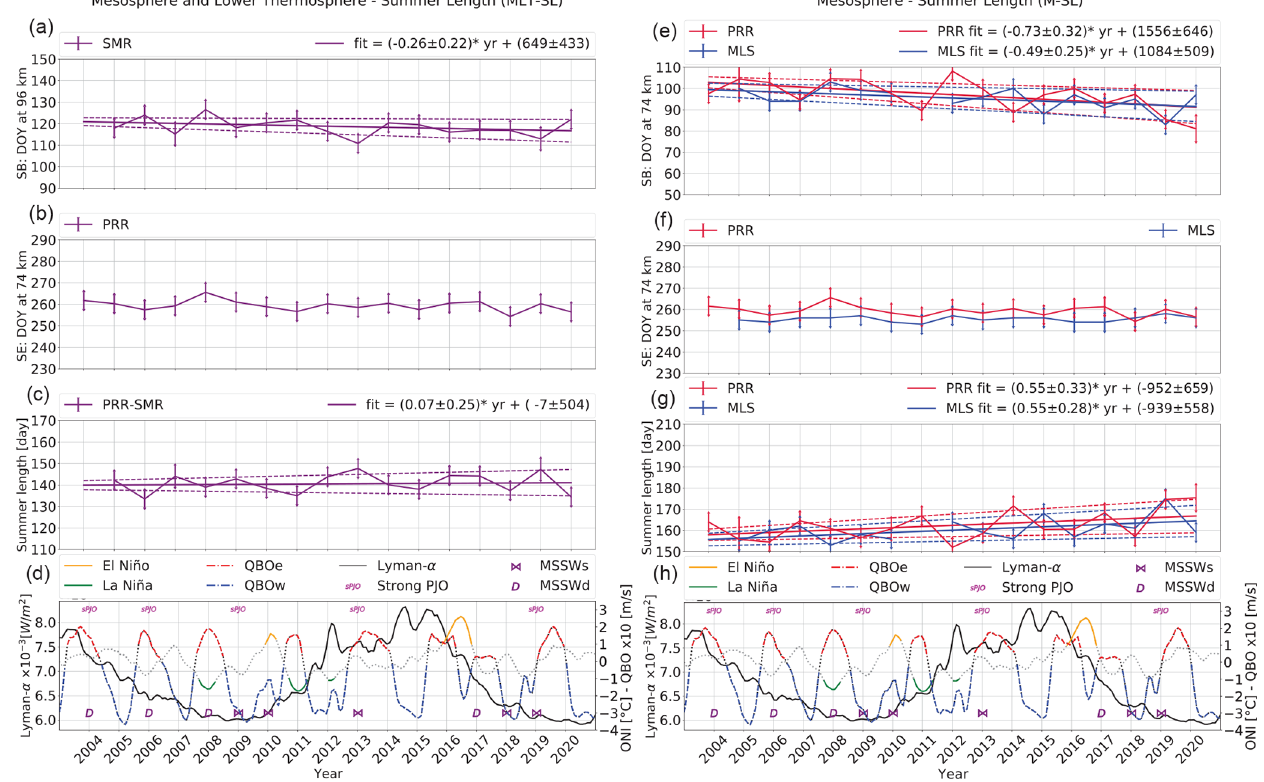
Figure 4. Summer length at middle latitudes: similar to Fig. 3, but in this case, the altitude of MLT-SE (b) is 74km as well as for M-SB (e) and M-SE (g) . At this latitude the MLT-SL is obtained from a combination of SMRs and PRR.